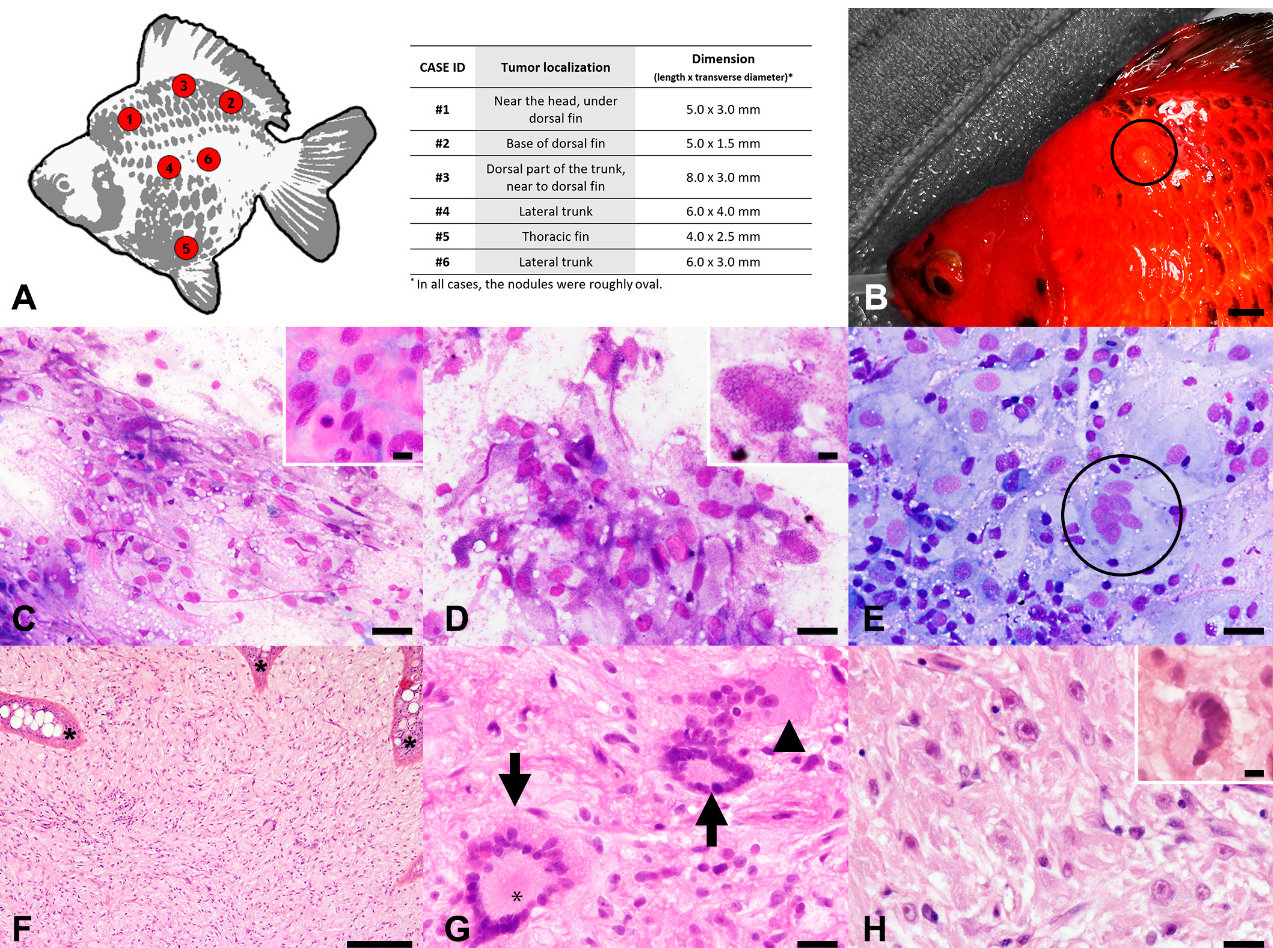
Figure 1. Atypical neurofibroma, skin, goldfish. ( A ) Localization of the nodules (left) and corresponding size (table on the right). ( B ) Case 1: Gross appearance of one of the nodules in situ (encircled). ( C ) Case 1: Fine needle aspiration smear of the nodule with discrete or loosely cohesive, spindle-shaped to polygonal-shaped atypical cells embedded in a finely fibrillar, compact, and pinkish extracellular matrix (insert). May-Grünwald-Giemsa (MGG). ( D ) Case 1: Atypical cells with small, magenta intracytoplasmic granules (insert). MGG. ( E ) Case 6: Presence of occasional multinucleated cells (encircled) within the tumors. MGG. ( F ) Case 3: Intradermal neoplasm composed of cells arranged in streams, loosely arranged interlacing bundles, whorls, or in a storiform pattern with hyperplasia of the overlying epidermis with rete ridge formation (asterisks). Hematoxylin and eosin (HE). ( G ) Case 3: Multifocal aggregates of cells palisading around a central area filled with fine eosinophilic fibrils lined by cell cytoplasms (asterisk), resembling rosettes of the pineocytomatous/neurocytic type (arrows), and a giant multinucleated neoplastic cell (arrowhead). HE. ( H ) Case 2: Spindle-shaped to polygonal-shaped tumor cells displayed moderate to marked anisocytosis, anisokaryosis, and macronucleolosis with prominent magenta nucleoli, with the occasional presence of atypical, large, hyperchromatic nuclei with smudgy chromatin (insert). HE. Scale bars: 0.5 cm ( B ), 100 µ m ( F ), 20 µ m ( C – E , G , H ), 10 µ m (( C ) insert, ( D ) insert, ( H ),